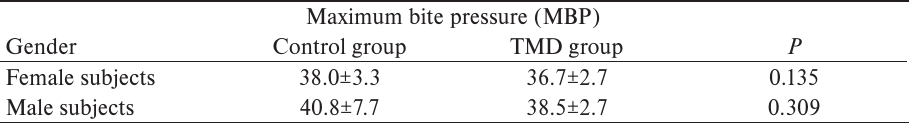
Table 1. Comparative analysis of MBP between female and male subjects of the observed group.